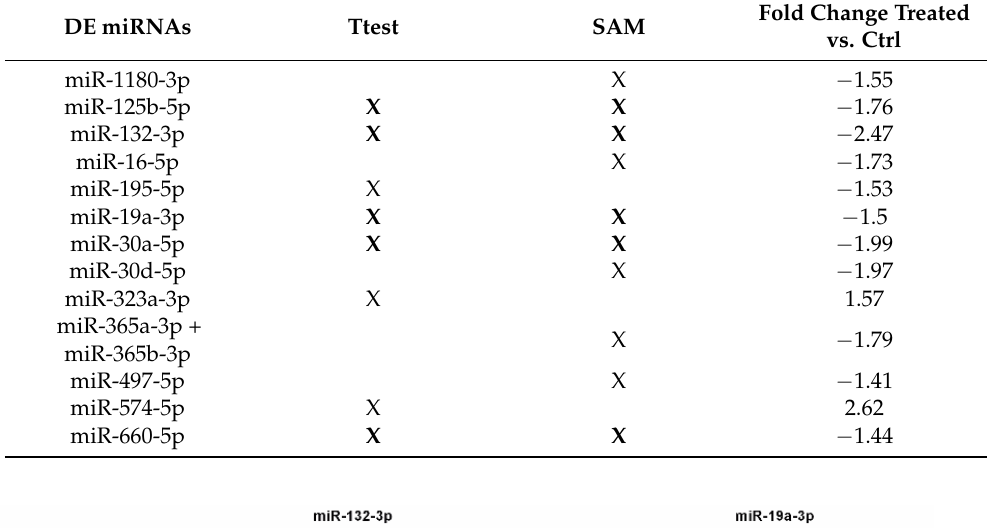
Table 2. List of DE miRNAs in resveratrol treated FF samples vs. CTRL. DE miRNAs were selected according to Volcano Plot and SAM statistical tests. DE miRNAs common to both statistical tests and chosen for further analyses are highlighted in bold. The FC value of each miRNA is reported.